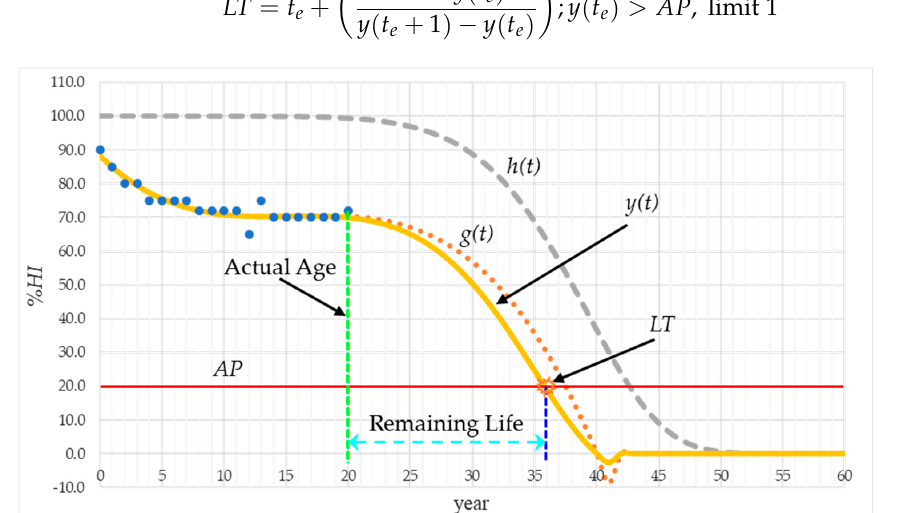
Figure 6. Lifetime curve estimation after the combination of predictive health index and conditional factor.